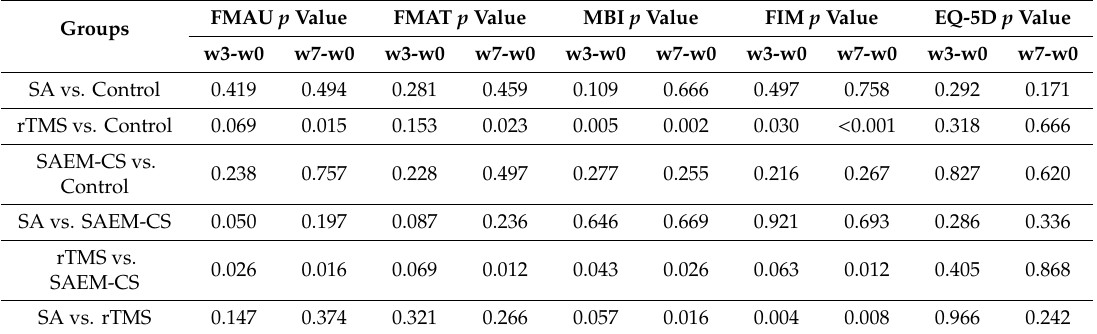
Table 5. Multiple comparisons of FMAUE, FMAT, MBI, FIM, and EQ-5D scores among the four groups.